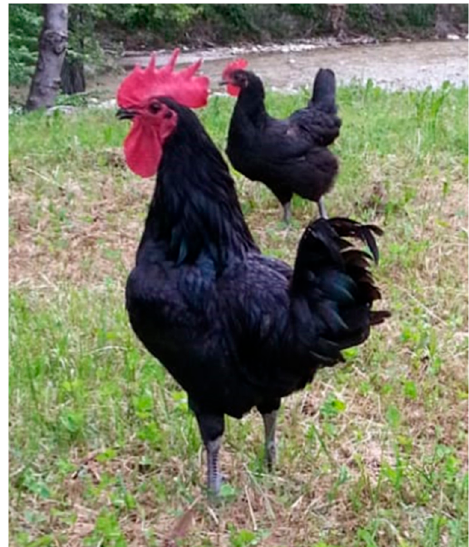
Figure 1. The Nera Atriana laying hen. These are hens with relatively small size, dark plumage with green, blue, and purple reflections, black skin and grey beak.